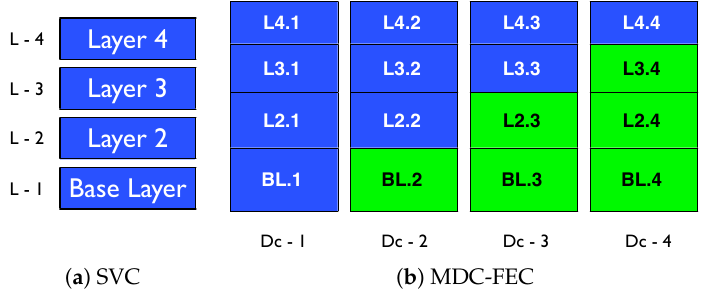
Figure 1. An example of a four-layered SVC stream encoded as MDC-FEC (blue/dark colour denotes original SVC data, green/light colour denotes additional FEC